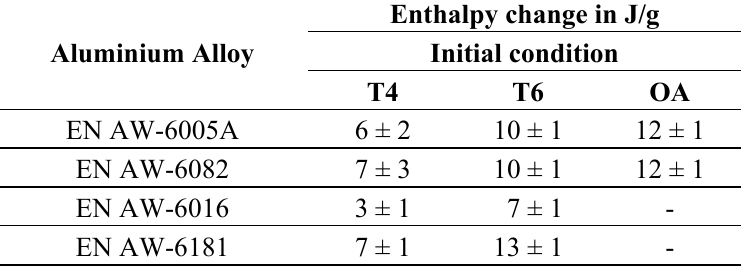
Table 3. Enthalpy change for the specific initial heat treatment states of the investigated aluminium alloys in